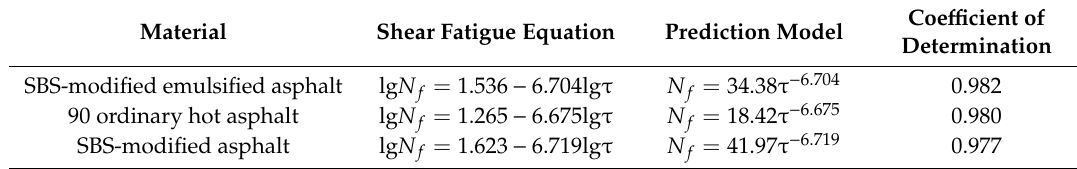
Table 9. Shear fatigue equations for di ff erent waterproof cohesive layer materials.